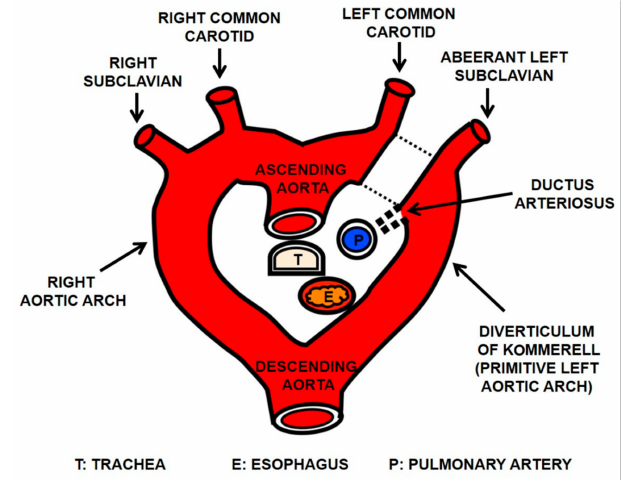
Figure 1. Diagram explaining the right aortic arch with aberrant left subclavian artery (ALSA) arising from a diverticulum of Kommerell based on the double aortic arch hypothesis. This anomaly results from a regression of the left arch between the left common carotid and left subclavian arteries (dotted lines). The left subclavian artery arises as the last branch of right aortic arch (ALSA) and takes a retroesophageal course. A remnant of the left arch becomes a diverticulum of Kommerell from which the normal-sized ALSA continues. With the presence of ligamentum arteriosum, a vascular ring is formed. The esophagus is compressed posteriorly by the diverticular portion of the ALSA.